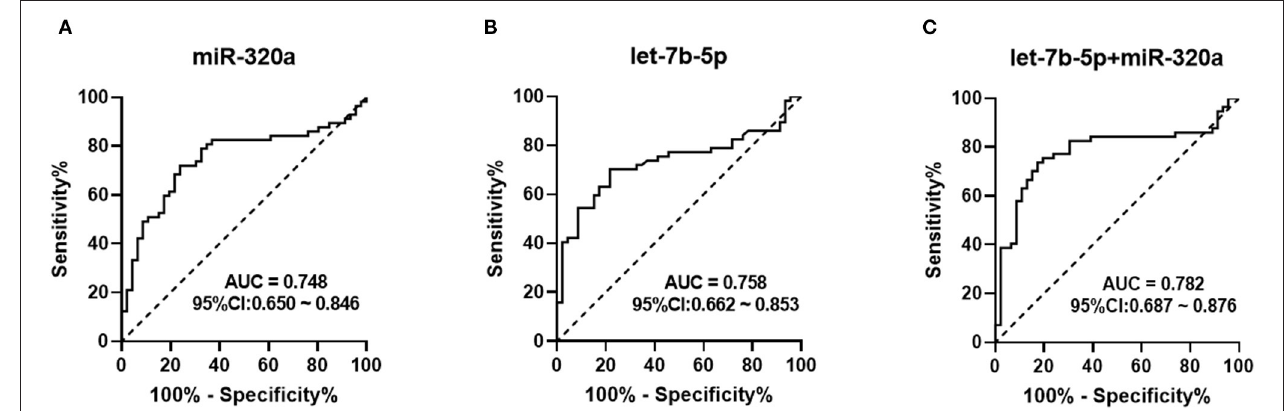
FIGURE 4 | Receiver Operation Characteristic (ROC) curve for the ability of miR-320a and let-7b-5p to distinguish heroin-dependent patients from healthy controls. AUC is the area under receiver-operator characteristic curve. The diagonal line represents a reference line of zero sensitivity and zero specificity. (A) ROC curve for miR-320a to discriminate heroin-dependent patients from healthy controls (AUC of 0.748, sensitivity = 71.9%, specificity = 76.1%, p < 0.0001); (B) ROC curve for let-7b-5p to discriminate heroin-dependent patients from healthy controls (AUC of 0.758, sensitivity = 70.2%, specificity = 78.3%, p < 0.0001); (C) ROC curve for a combination of let-7b-5p and miR-320a to discriminate heroin-dependent patients from healthy controls (AUC of 0.782, sensitivity = 73.7%, specificity = 82.6%, p < 0.0001).